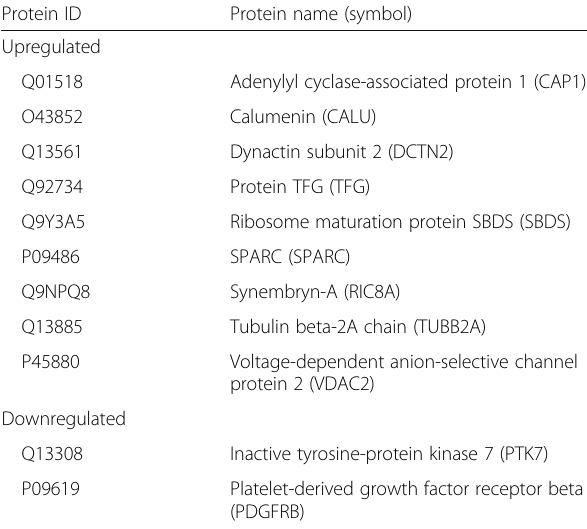
Table 1 List of differentially expressed proteins in young and senescent cells